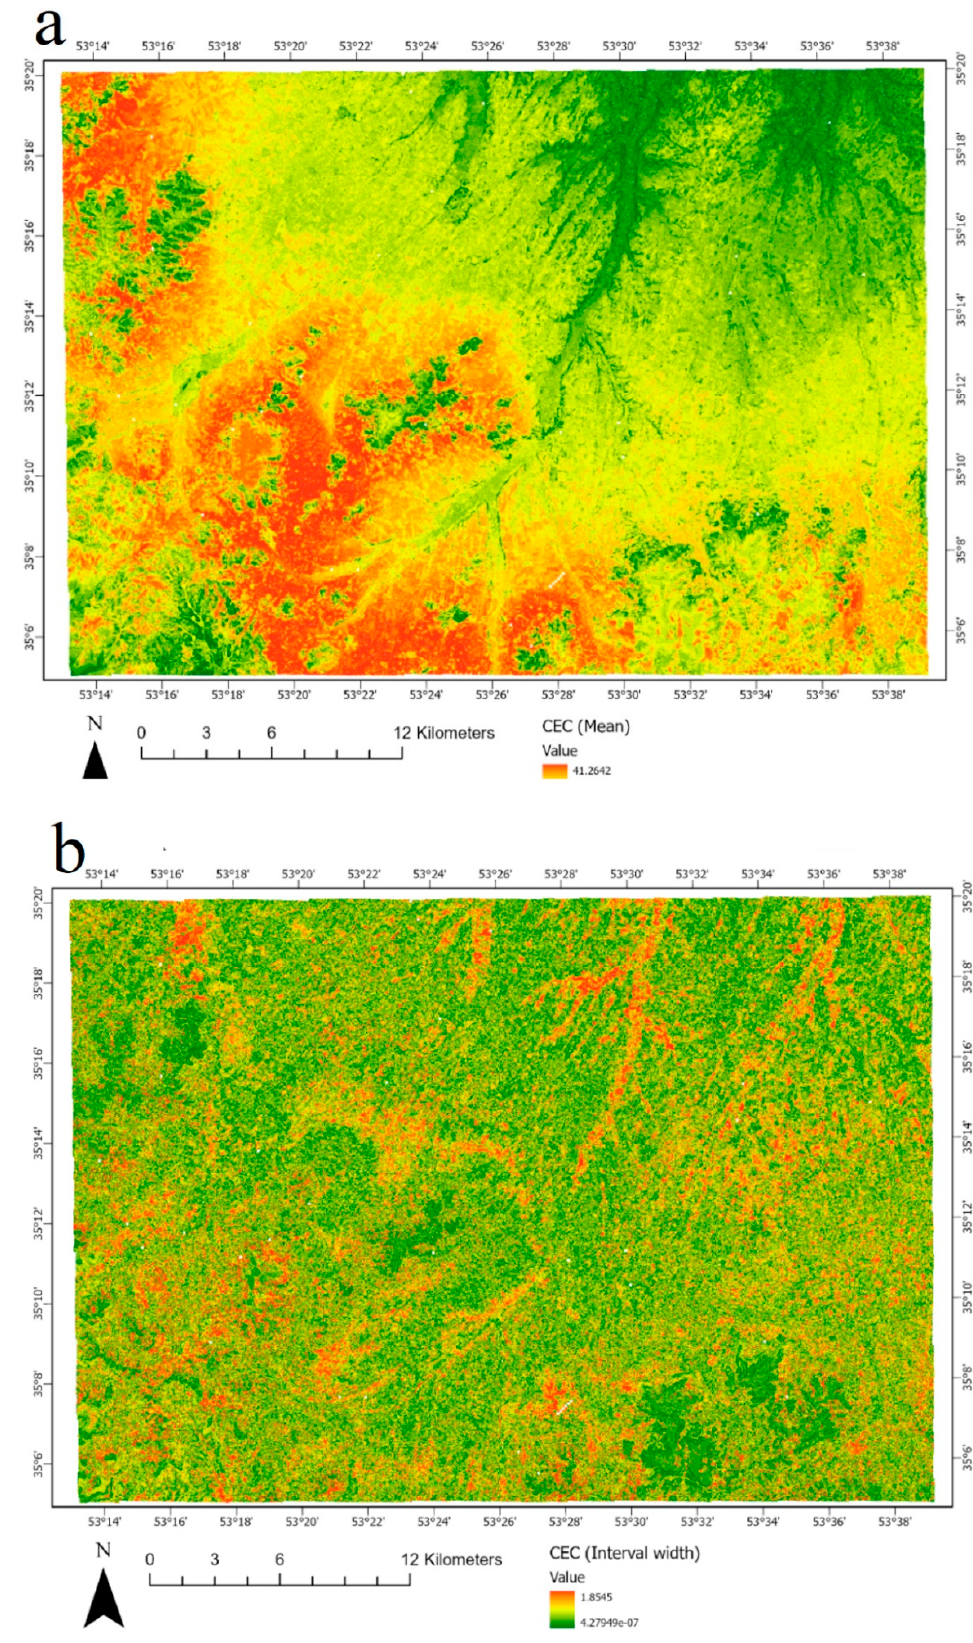
Figure 6. Predicted CEC ( a ) and associated uncertainty map (width of the 90% prediction interval) ( b ).